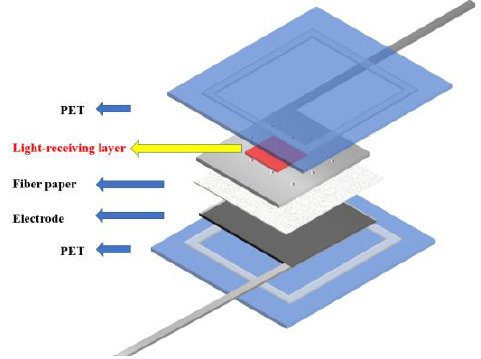
Figure 1. DSSC with external photoanode structure.